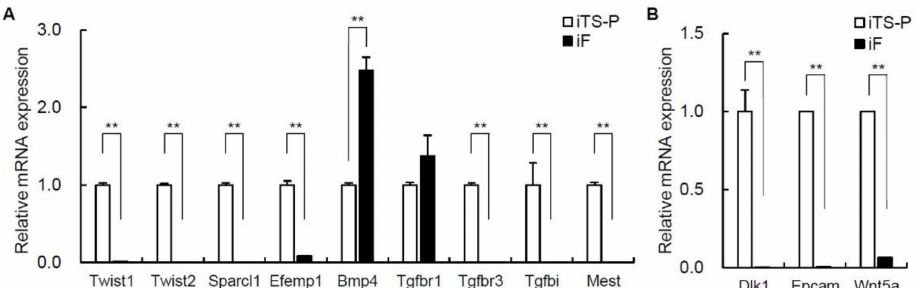
Figure 5. qRT-PCR analysis of epithelial-mesenchymal transition (EMT) markers and cell growth markers in iF cells (passage 30) and iTS-P cells (passage 30). ( A ) iTS-P cells and iF cells were evaluated for EMT markers using qRT-PCR. ( B ) iTS-P cells and iF cells were evaluated for cell growth markers using qRT-PCR. The data are expressed as the gene-to-Gapdh ratio, with this ratio for iTS-P cells arbitrarily set to 1 ( n = 3). The error bars indicate the standard error values. ** p <